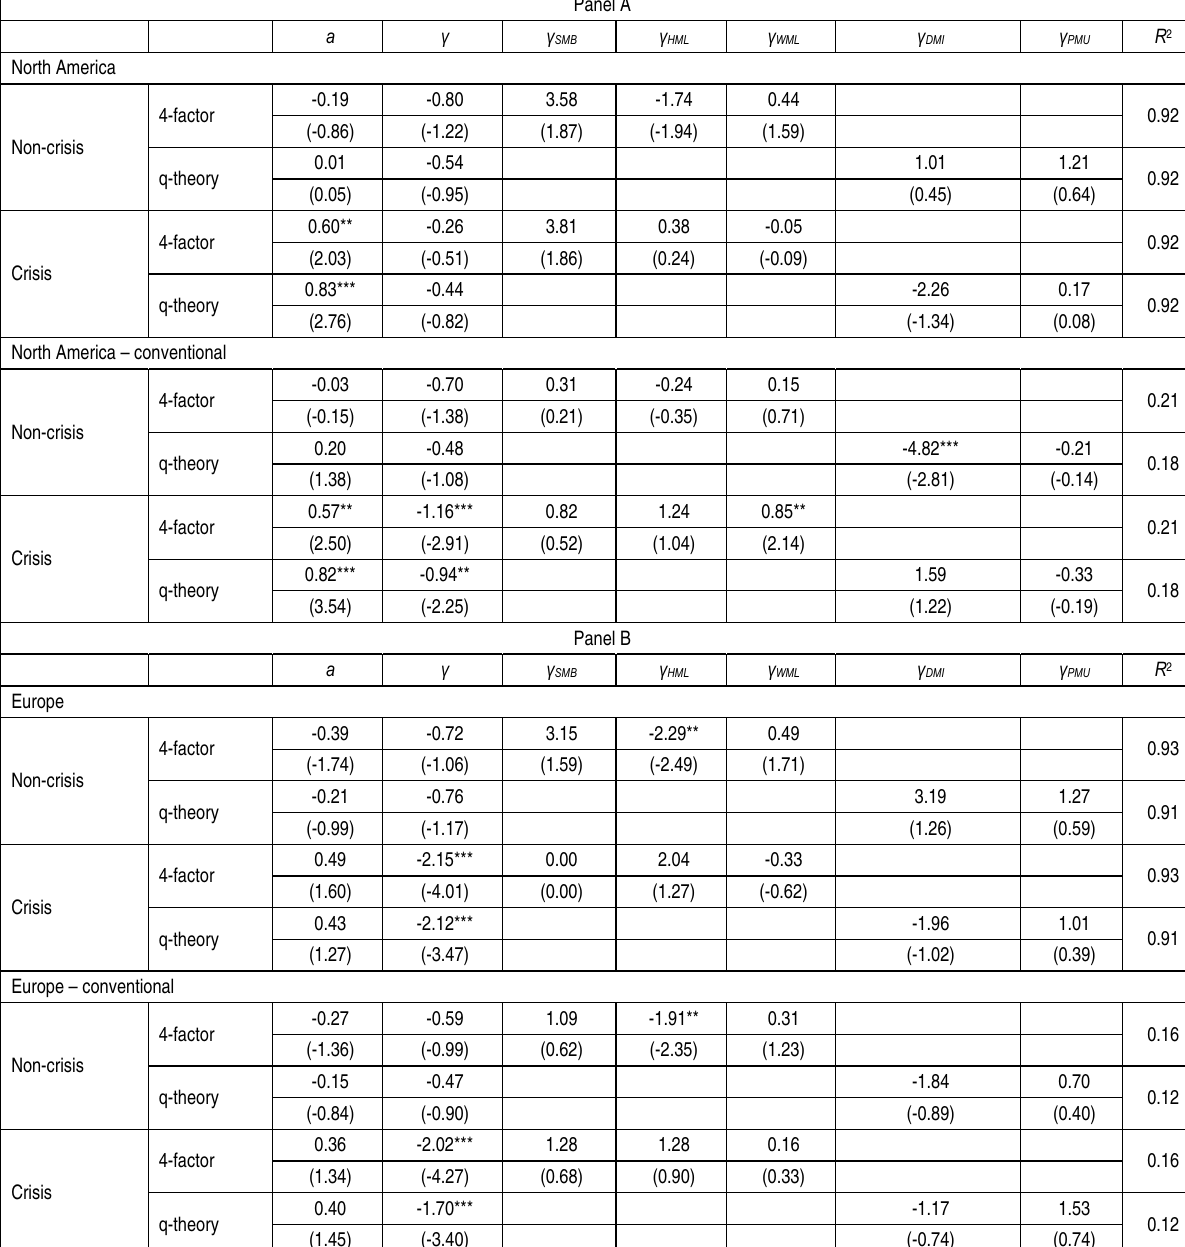
Table 4. Managerial abilities of North American, European, and Asian-Pacific funds Panel